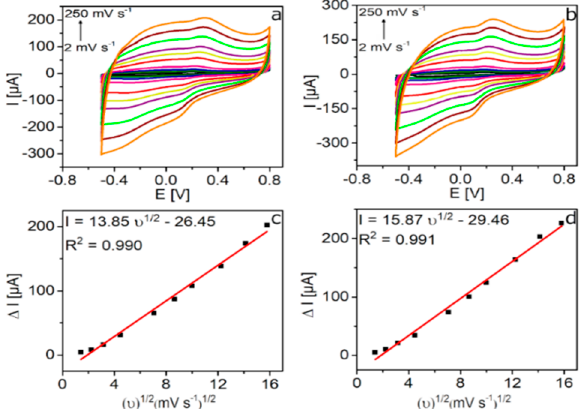
Figure 4. CVs recorded on ( a ) GCE/rGO-Au and ( b ) GCE/N-rGO-Au electrodes at different scan rates (2, 5, 10, 20, 50, 75, 100, 150, 200, 250 Mv·s − 1 ) in 0.1 PBS (pH 7.0) with 100 µM DA. Dependence of maximum anodic current against the square root of the scan rate for ( c ) GCE/rGO-Au and ( d ) GCE/N-rGO-Au.